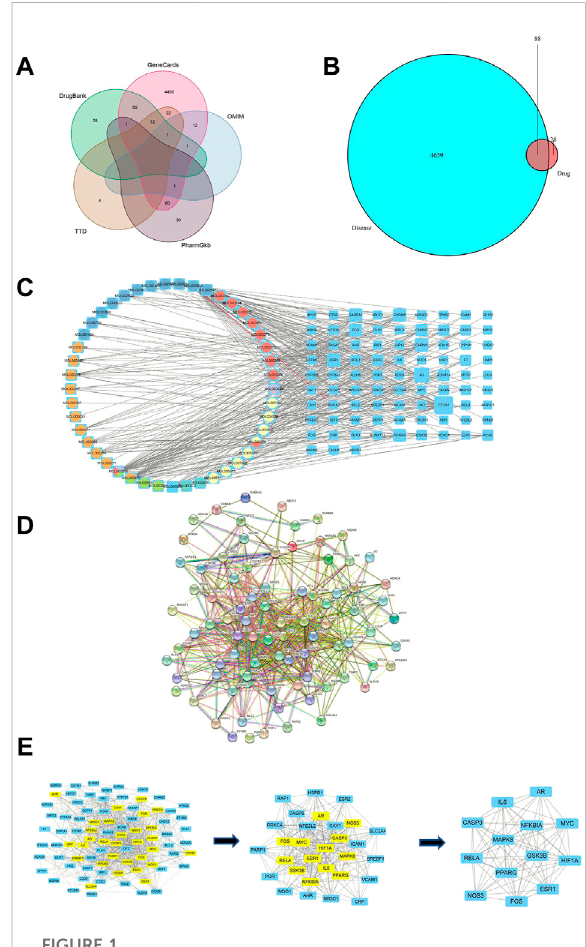
FIGURE 1 Network construction and PPI network core screening. (A) Venn diagram of the fi ve databases surveyed. (B) The intersections between targets associated with RSYRD and MI. (C) Network of bioactive compounds — targets — disease. Yellow-orange: Hedysarum Multijugum Maxim.; blue: Coptidis Rhizoma; orange- red: Poria Cocos (Schw.) Wolf.; purple: Angelicae Sinensis Radix; green blue: Atractylodes Macrocephala Koidz.; green: